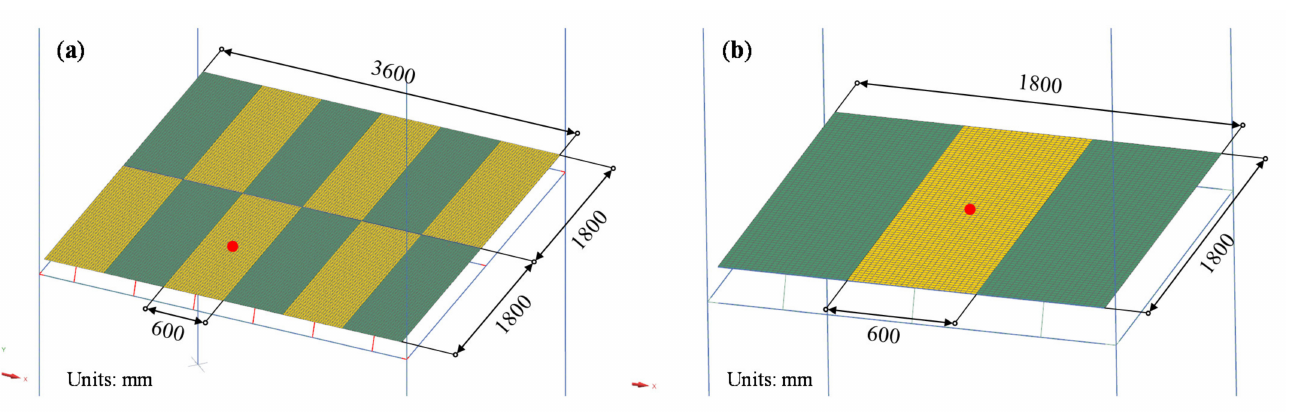
Figure 8. ( a ) Basic numerical model; ( b ) modified numerical model with different beam structure but the same ALC panel size.